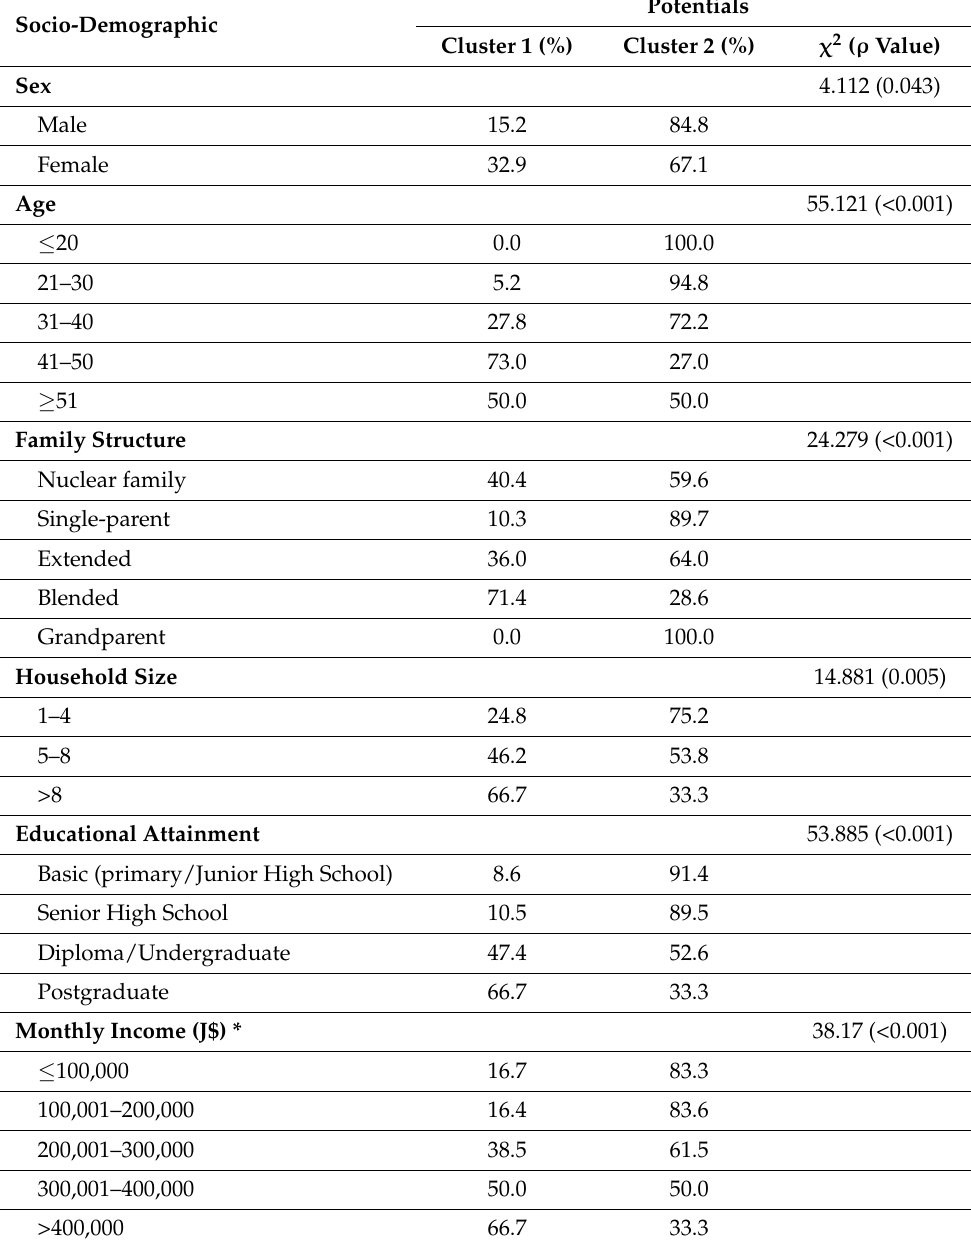
Table 7. Parents cluster profiles by socio-demographic